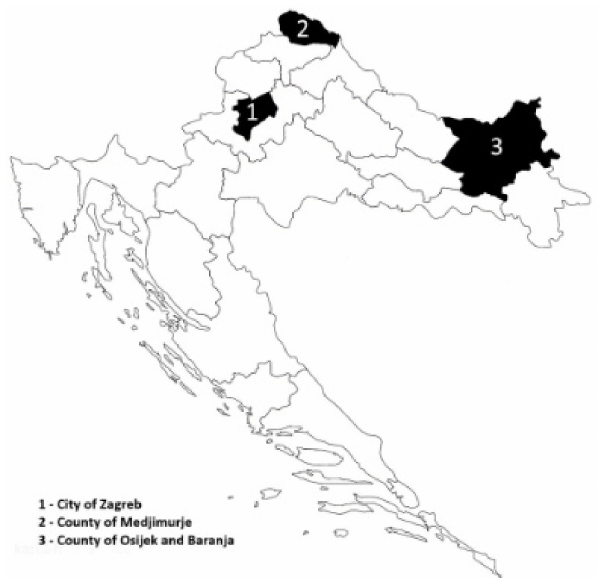
Figure 1. Sampling locations in